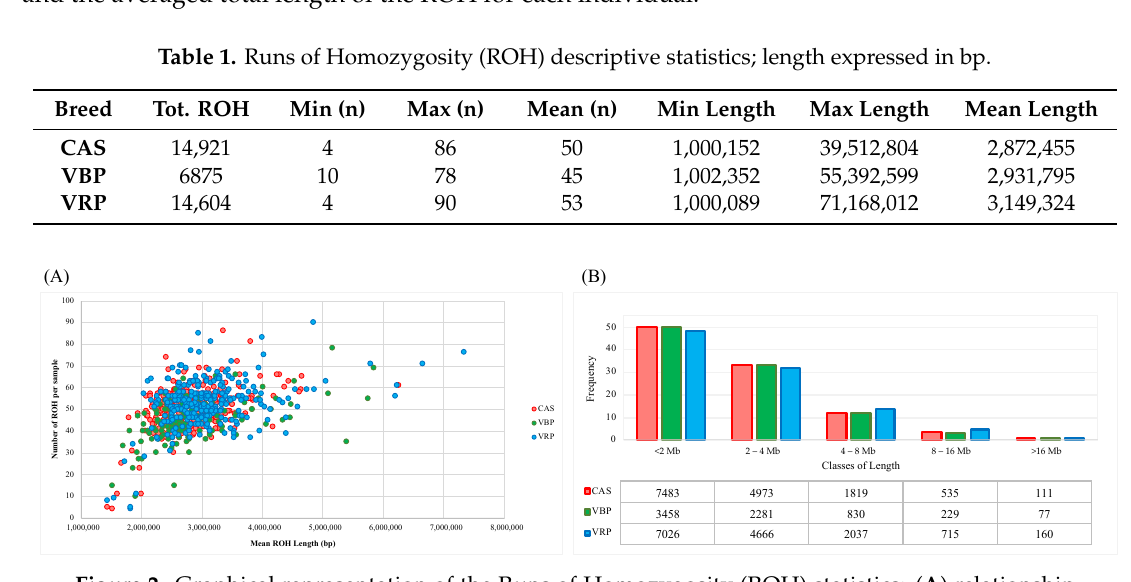
Figure 2. Graphical representation of the Runs of Homozygosity (ROH) statistics: ( A ) relationship between the number and mean total length of the ROH in each sample / breed; ( B ) frequencies and counts of the ROH for each class of length calculated within each